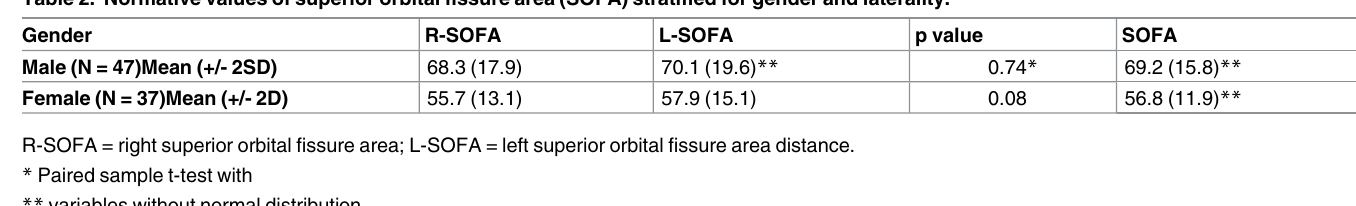
Table 2. Normative values of superior orbital fissure area (SOFA) stratified for gender and laterality. Gender